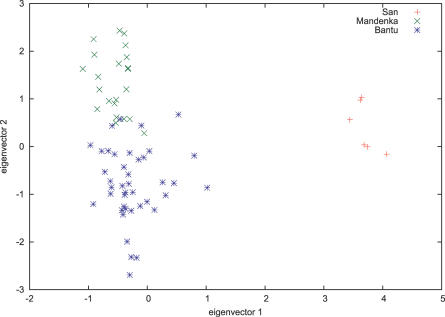
Three African PopulationsPlots of the first two eigenvectors for some African populations in the CEPH–HGDP dataset [30]. Yoruba and Bantu-speaking populations are genetically quite close and were grouped together. The Mandenka are a West African group speaking a language in the Mande family [15, p. 182]. The eigenanalysis fails to find structure in the Bantu populations, but separation between the Bantu and Mandenka with the second eigenvector is apparent.